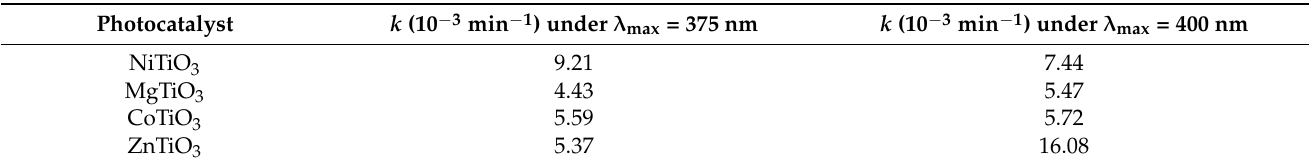
Table 3. Photocatalytic reaction rate constants under LED illumination of metal titanate nanorods ATiO 3 (A = Mg, Co, Ni, Zn).